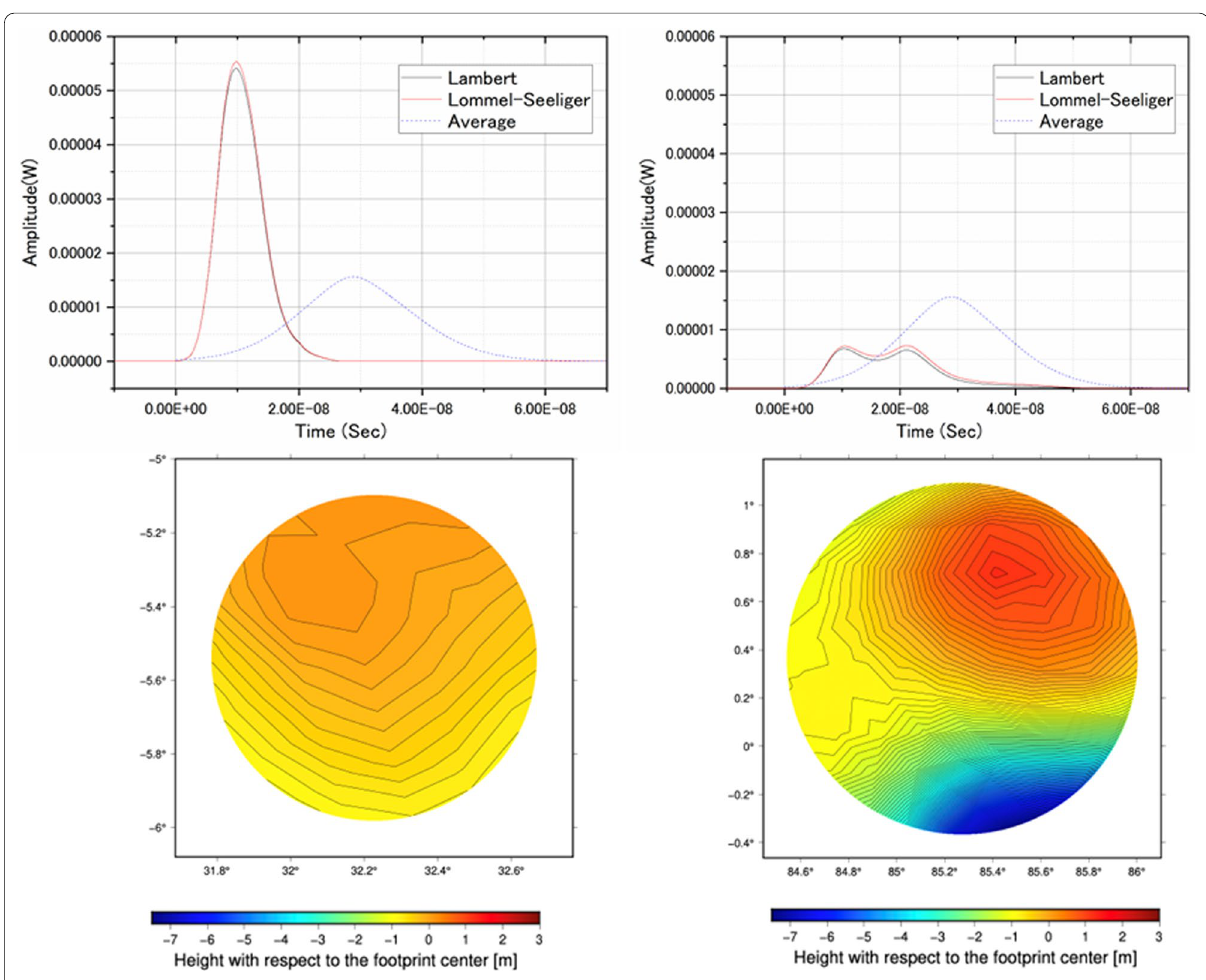
Fig. 9 Examples of the calculated return pulse waveforms and the corresponding footprint topographies derived from the Ryugu shape model. (Left) The transmitted time is 17:33:56 on 1 August 2018. The transmitted energy is 0.00151 J. Distance between the spacecraft and the footprint center is 5155 m. The mean incident angle in the footprint is 0.204 rad. (Right) The transmitted time is 8:44:06 on 1 August 2018. The transmitted energy is 0.00133 J. Distance between the spacecraft and the footprint center is 8589 m. The mean incident angle in the footprint is 0.464 rad. The blue dotted line shows the average of 25,964 return pulses taken on 3-October